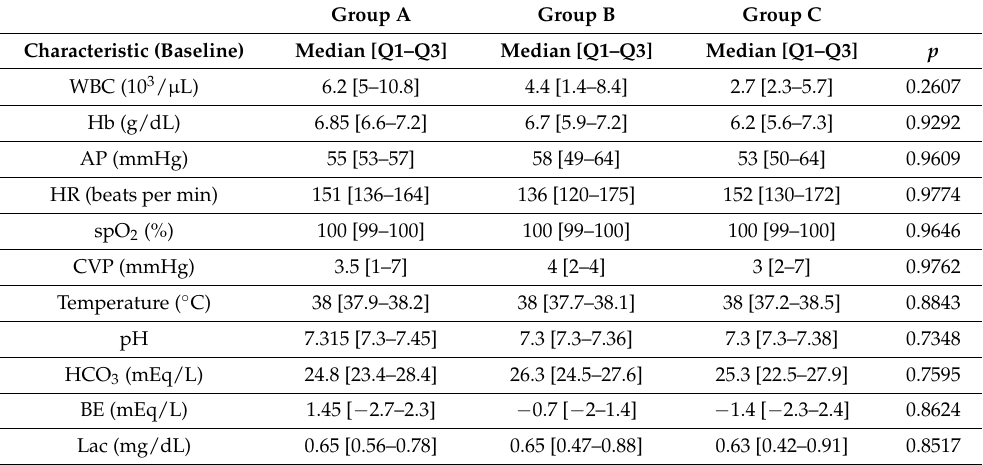
Table 2. Animal characteristics at baseline. Venous and arterial blood samples and hemodynamic parameters. WBC = White Blood Cells, Hb = hemoglobin, AP = Arterial Pressure, HR = Heart Rate, spO 2 = Oxygen saturation, CVP = Central venous pressure, pH = potential of hydrogen, HCO 3 = Bicarbonate, BE = Base Excess, Lac =